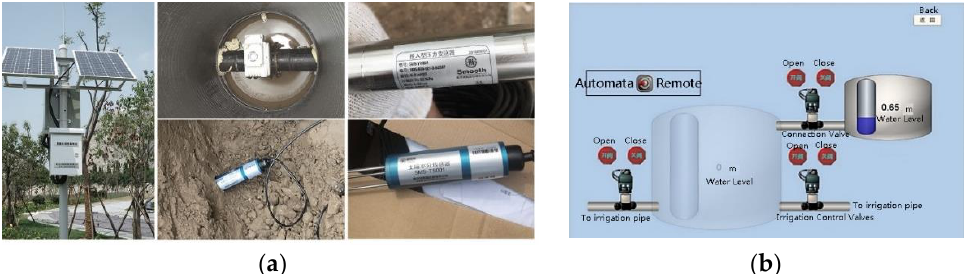
Figure 5. Pictures of sensor system setup ( a ), and terminal interface of water real-time intelligent control system ( b ).